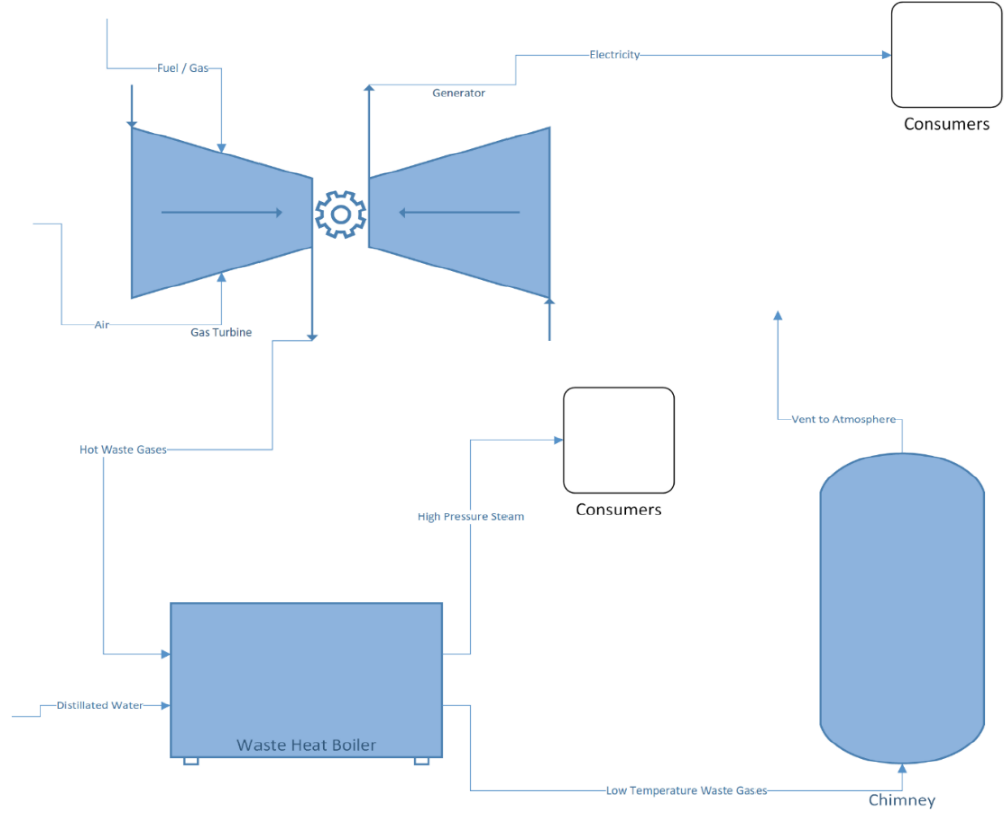
Fig. 1. The schematic diagram of a combined cycle power